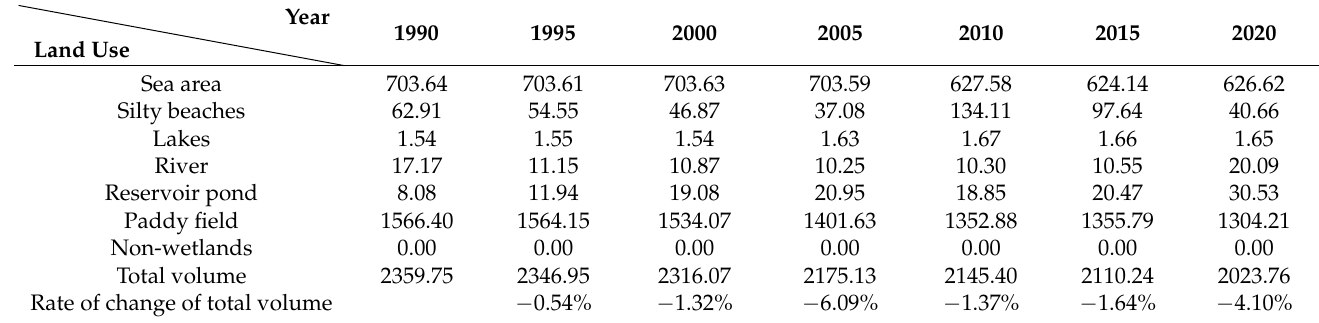
Table 3. Carbon storage by land use in the Hangzhou Bay wetlands from 1990 to 2020 (Unit: 10 4